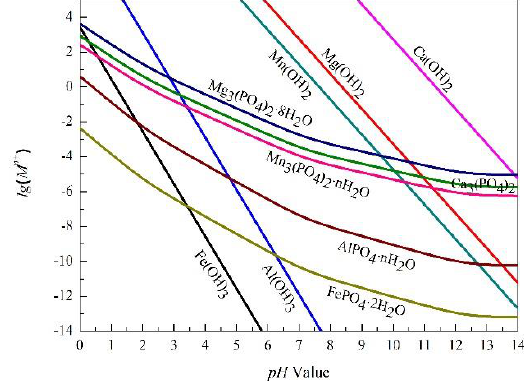
Figure 3. Relationship between lg(M n+ ) and pH.